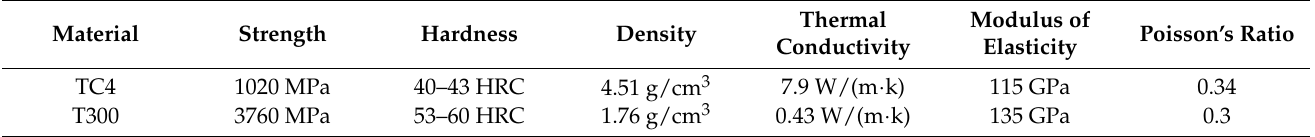
Table 1. Properties of Ti6Al4V and T300